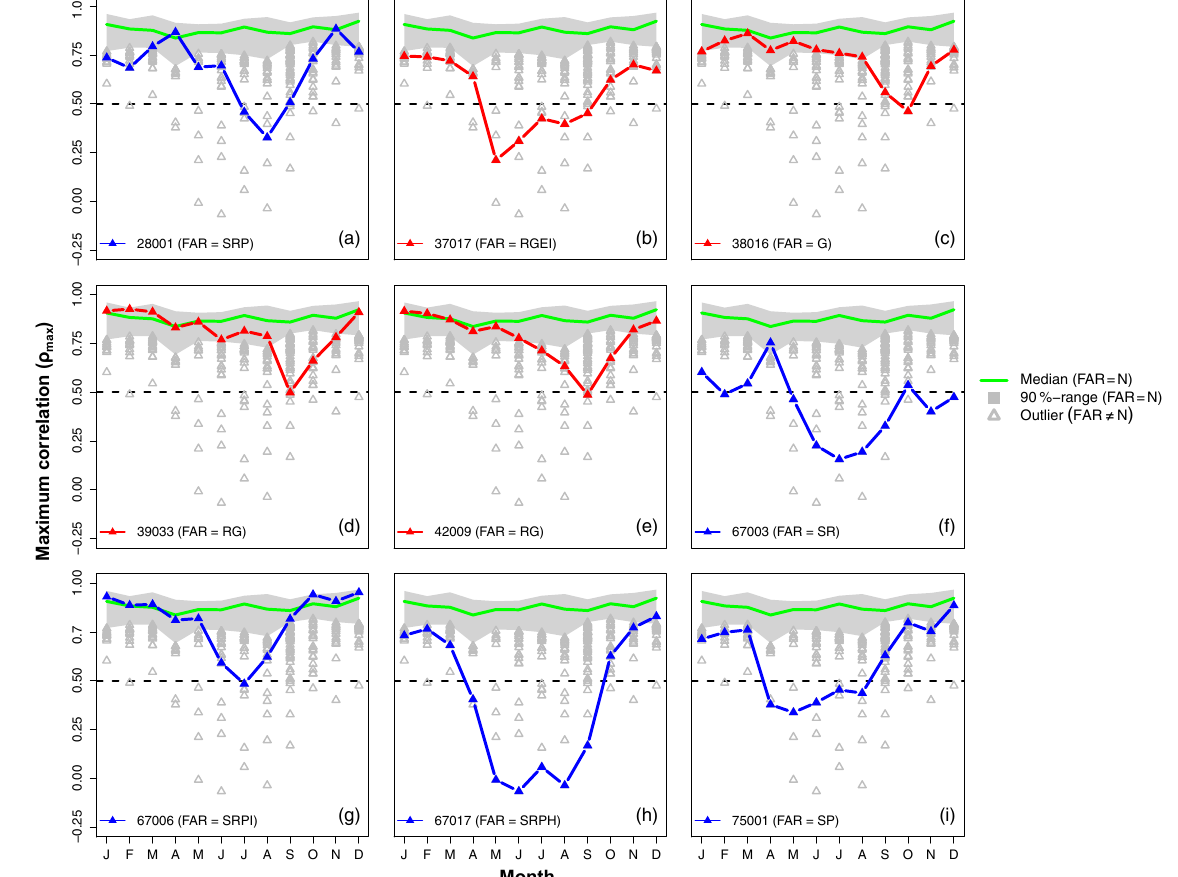
Figure 6. Maximum rank correlation ( ρ max ) between streamflow ( Q ) and precipitation accumulated over different time periods ( P n ) for catchments with near-natural flow (FAR = N). Grey triangles reflect ρ max of influenced catchments (FAR = N) below the 90% range of catchments with near-natural flow. Coloured lines show ρ max of stations with at least 1 month ρ max < 0 . 5.